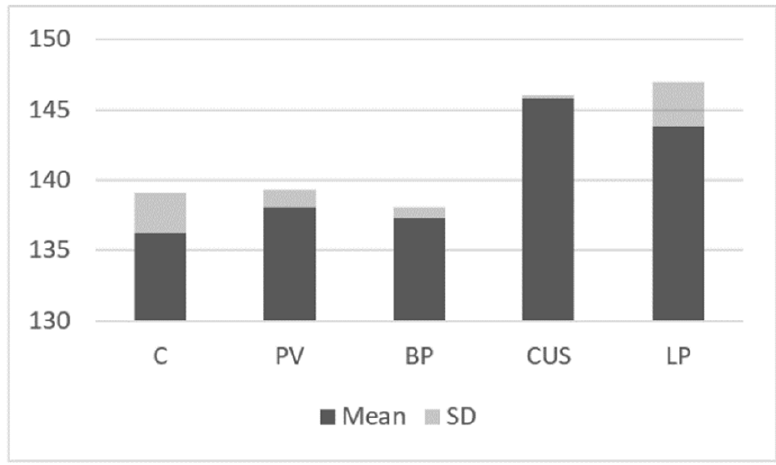
Figure 5. Immunoblotting.STAT2 expression in studies groups and control group. The intensity of STAT4 expression was higher in PV patients (138.39 ± 0.84) and BP patients (141.2 ± 0.05) as compared to the control group (121.63 ± 1.75; p < 0.05). There was also statistical significance between expression of STAT4 in CUS and LP patients (Figure